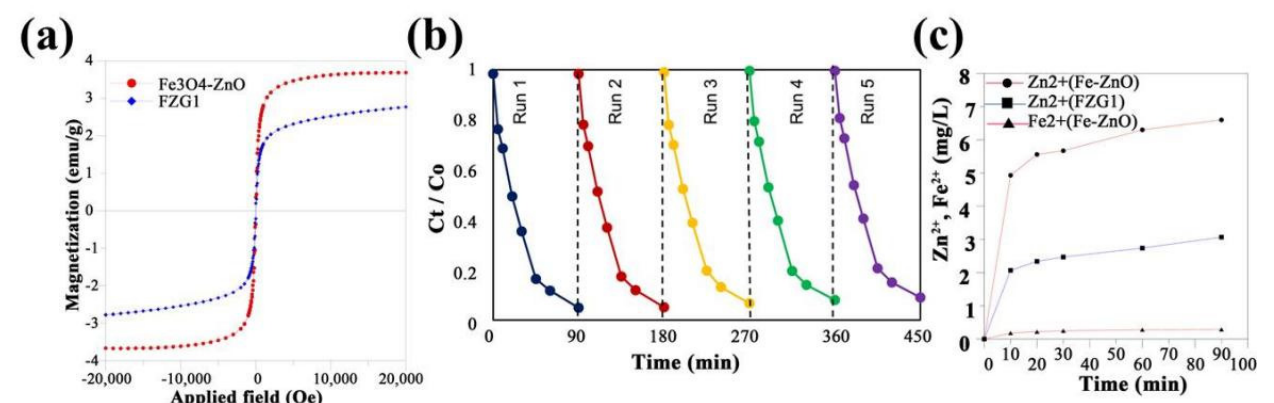
Figure 13. ( a ) Magnetization curves of Fe 3 O 4 − ZnO and FZG1; ( b ) release of zinc and iron ions into the solution as a function of time for Fe − ZnO and FZG1; ( c ) recyclability of FZG1 for photocatalytic degradation of SMX. Used with permission from [142]. Copyright 2018 Elsevier.